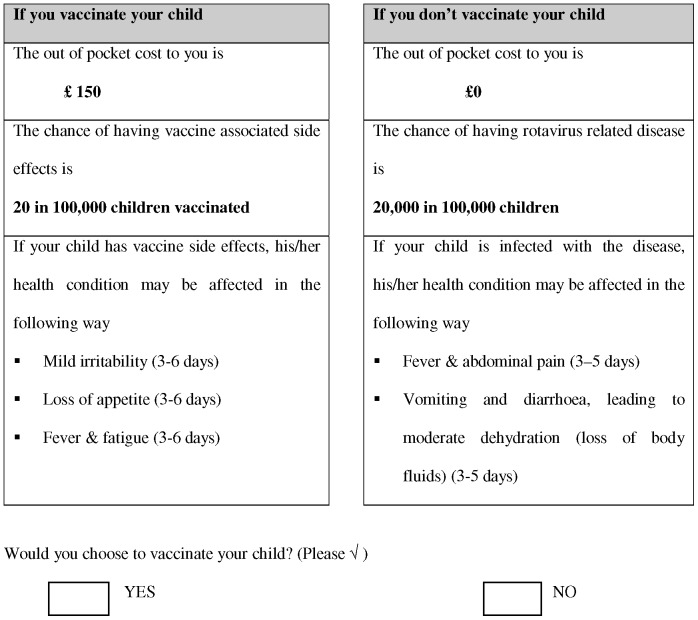
Sample choice set.